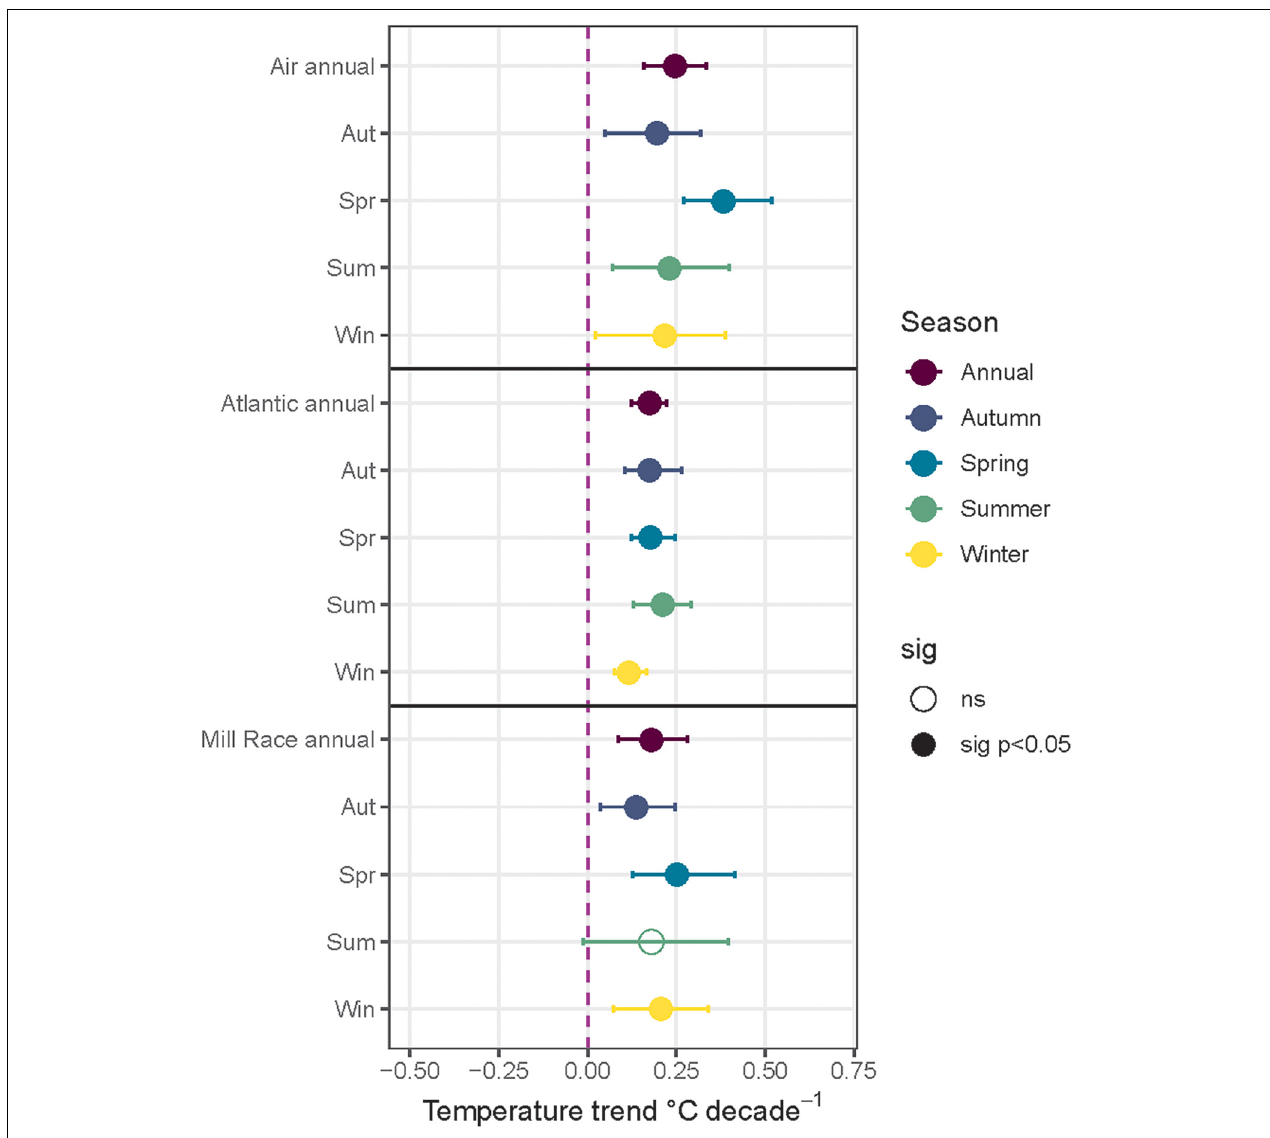
FIGURE 2 | Decadal trends in mean temperature ( ◦ C decade − 1 ) measured between 1970 and 2020 at Furnace Meteorological station (air), the Mill race channel (water) and the Atlantic Ocean (water) west of Achill Island (54 ◦ N and 10 ◦ W). Dots indicate the Theil-Sens estimate of the trend (slope) for each variable, and error bars denote the 95% confidence intervals (c.i.) of the estimate. The dashed purple line indicates a slope of 0, i.e., no trend. Filled circles indicate a significant trend at p < 0.05. Open circles indicate a non-significant